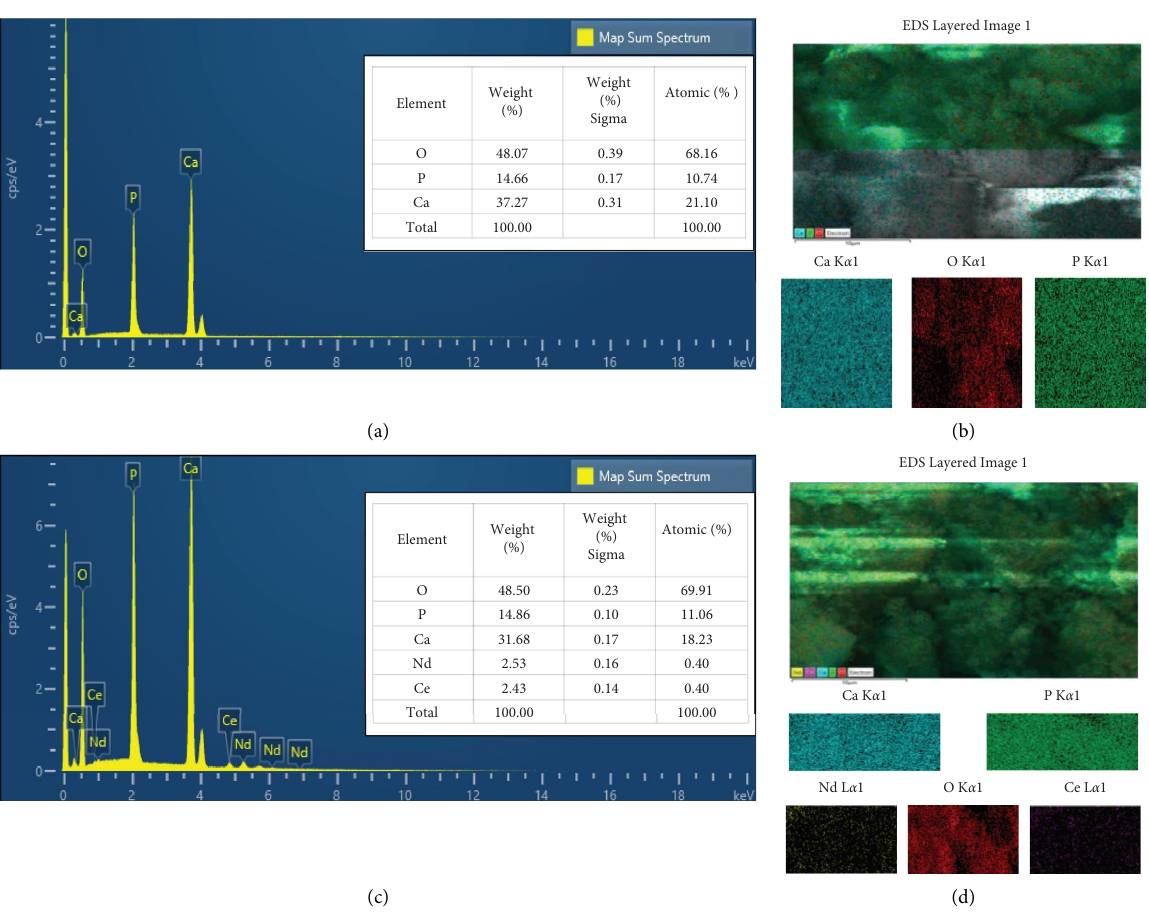
Figure 5: Chemical composition with elemental distribution to illustrate (a) EDS of HA, (b) HA mapping, (c) EDS of Nd-Ce/HA, and (d) Nd-Ce/HA mapping.